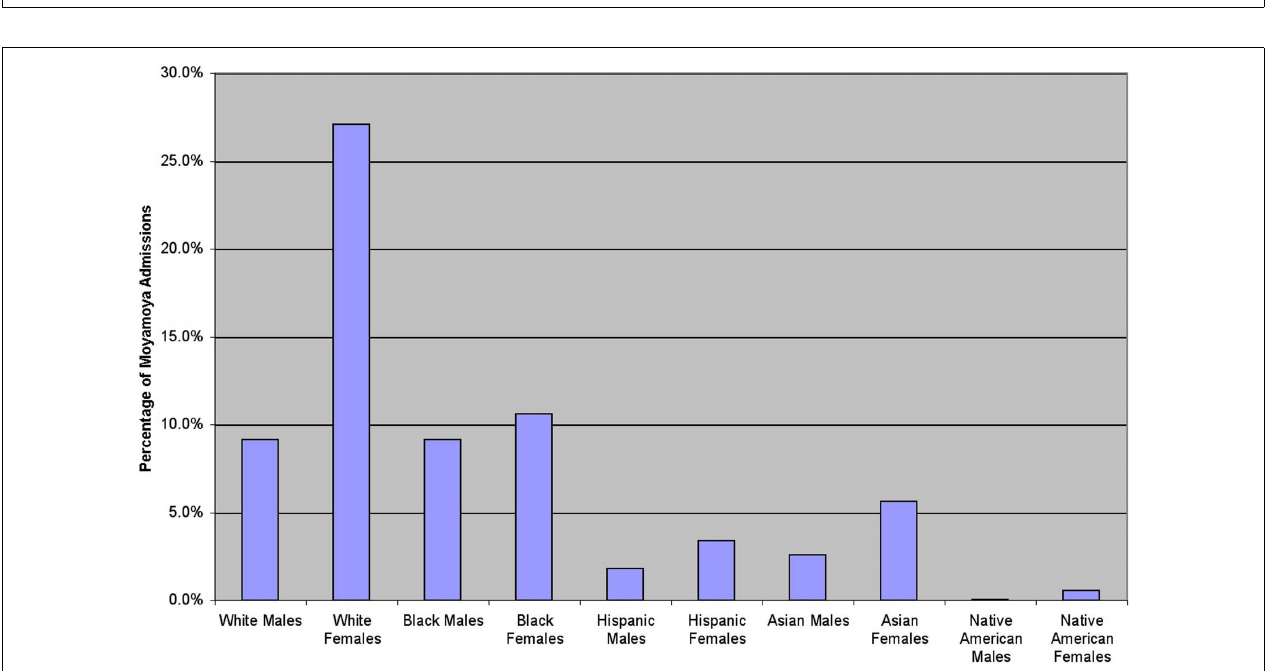
FIGURE 2 | In theUnited States, there is a predominance of female-to-male admissions for moyamoya. Over this time period, there is a similar number ofWhite and African American males, while moreWhite than African American females were admitted to the hospital with moyamoya during that time.